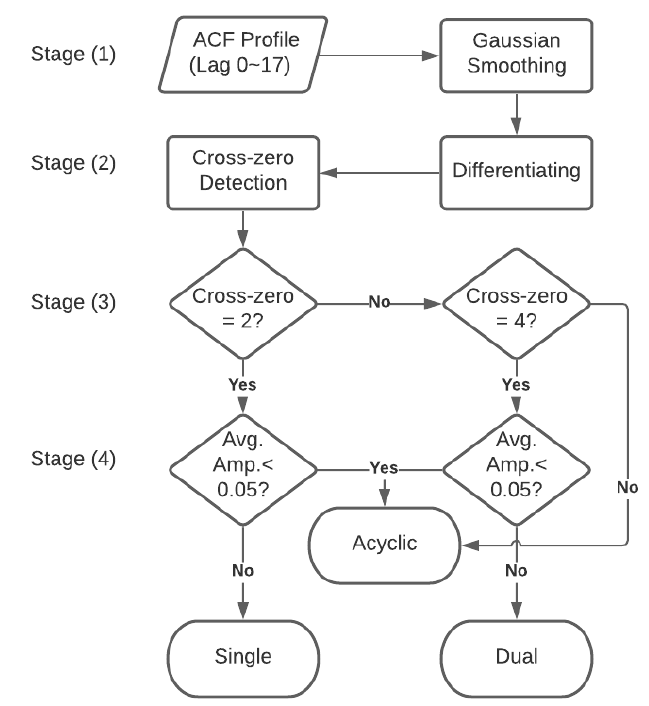
Figure 14. Flowchart of the ACF rule based classification.